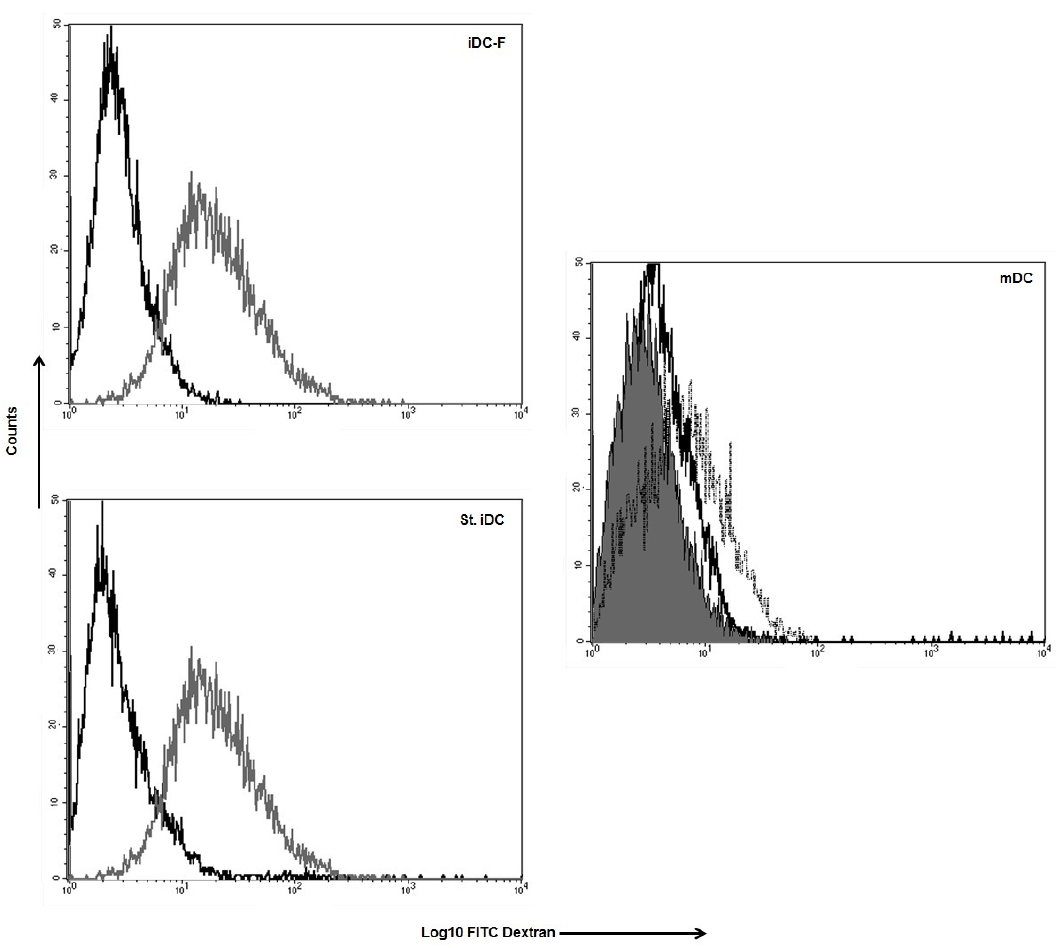
Figure 3. Uptake of FITC labeled dextran by DC. Histograms show the FACS analysis of the cell co-cultured with FITC labeled dextran at 37 ◦ C (grey line) and non-specific labeling of the cells (black line) for iDC-F (immature Fast-DC); St. iDC (standard method immature DC). Mature DC (mDC) were analysed as negative control for dextran uptake (dotted line Fast method; black line standard method; solid line isotype). One representative performed experiment is presented.